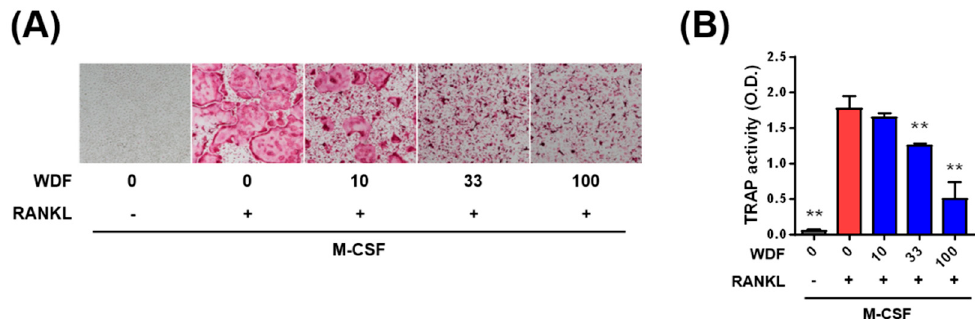
Figure 2. Effects of WDR on osteoclast differentiation in vitro. ( A ) Tartrate-resistant acid phosphatase (TRAP) staining and ( B ) TRAP activity of osteoclasts induced by RANKL in BMMs. BMMs were cultured for four days with or without WDR (10–100 µg/mL) and RANKL (50 ng/mL) in the presence of M-CSF (60 ng/mL). Results are presented as mean ± SEM and analyzed using a one-way analysis of variance and Dunnett's post hoc test. ** p < 0.01 versus the RANKL control group.